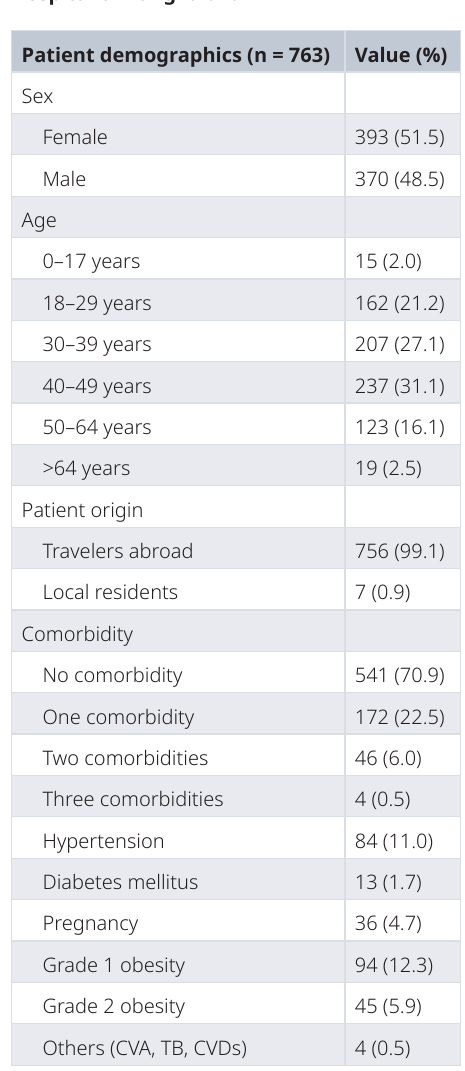
Table 1. Demographic characteristics of patients at the COVID-19 Emergency Field Hospital of